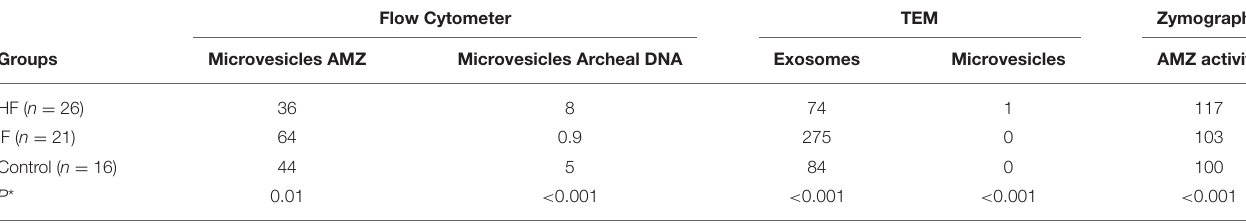
TABLE 1 | Median numbers of microvesicles in sera by flow cytometer with AMZ1 antigens and archaeal DNA.